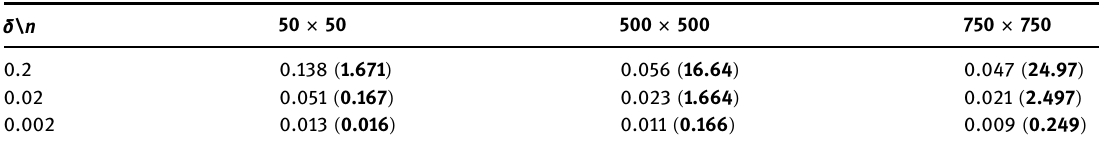
Table 2: l 2 - relative errors in the recovered gradients for Example 5.2 for several sample sizes n and noise levels δ . Numbers in parenthesis represent the relative errors computed from the noisy data